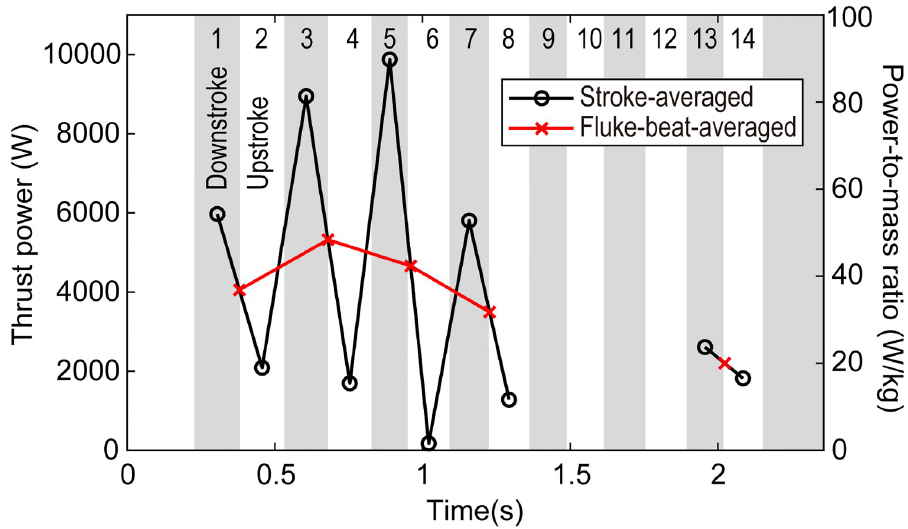
Fig 12. Stroke-averaged and fluke-beat-averaged thrust power and power-to-mass ratio. Grey region and white region represent downstroke and upstroke, respectively. See also S6 Dataset for each value.